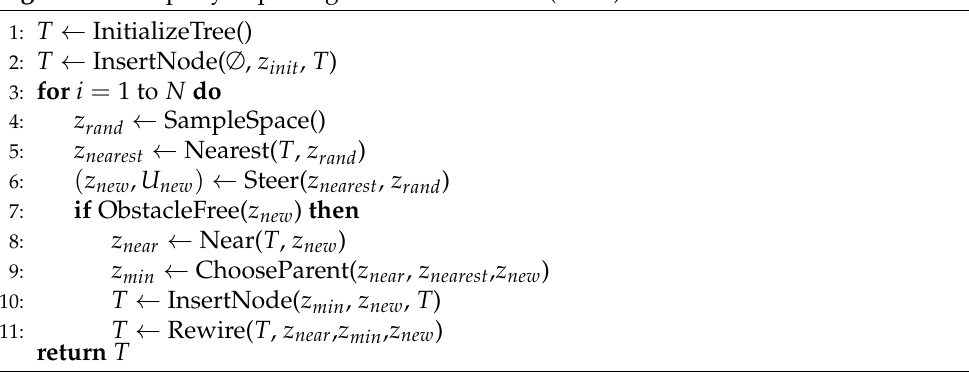
Algorithm 2 Rapidly-exploring Random Tree Star